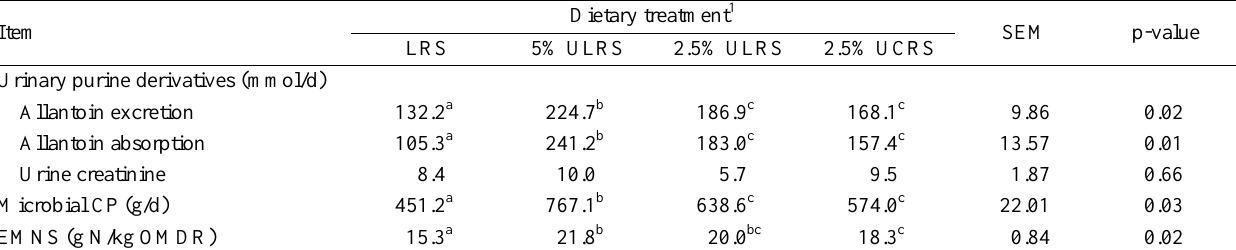
Table 4. Effects of physical forms and urea treatment of rice straw on excretion of urinary purine derivatives, and microbial CP synthesis in lactating dairy